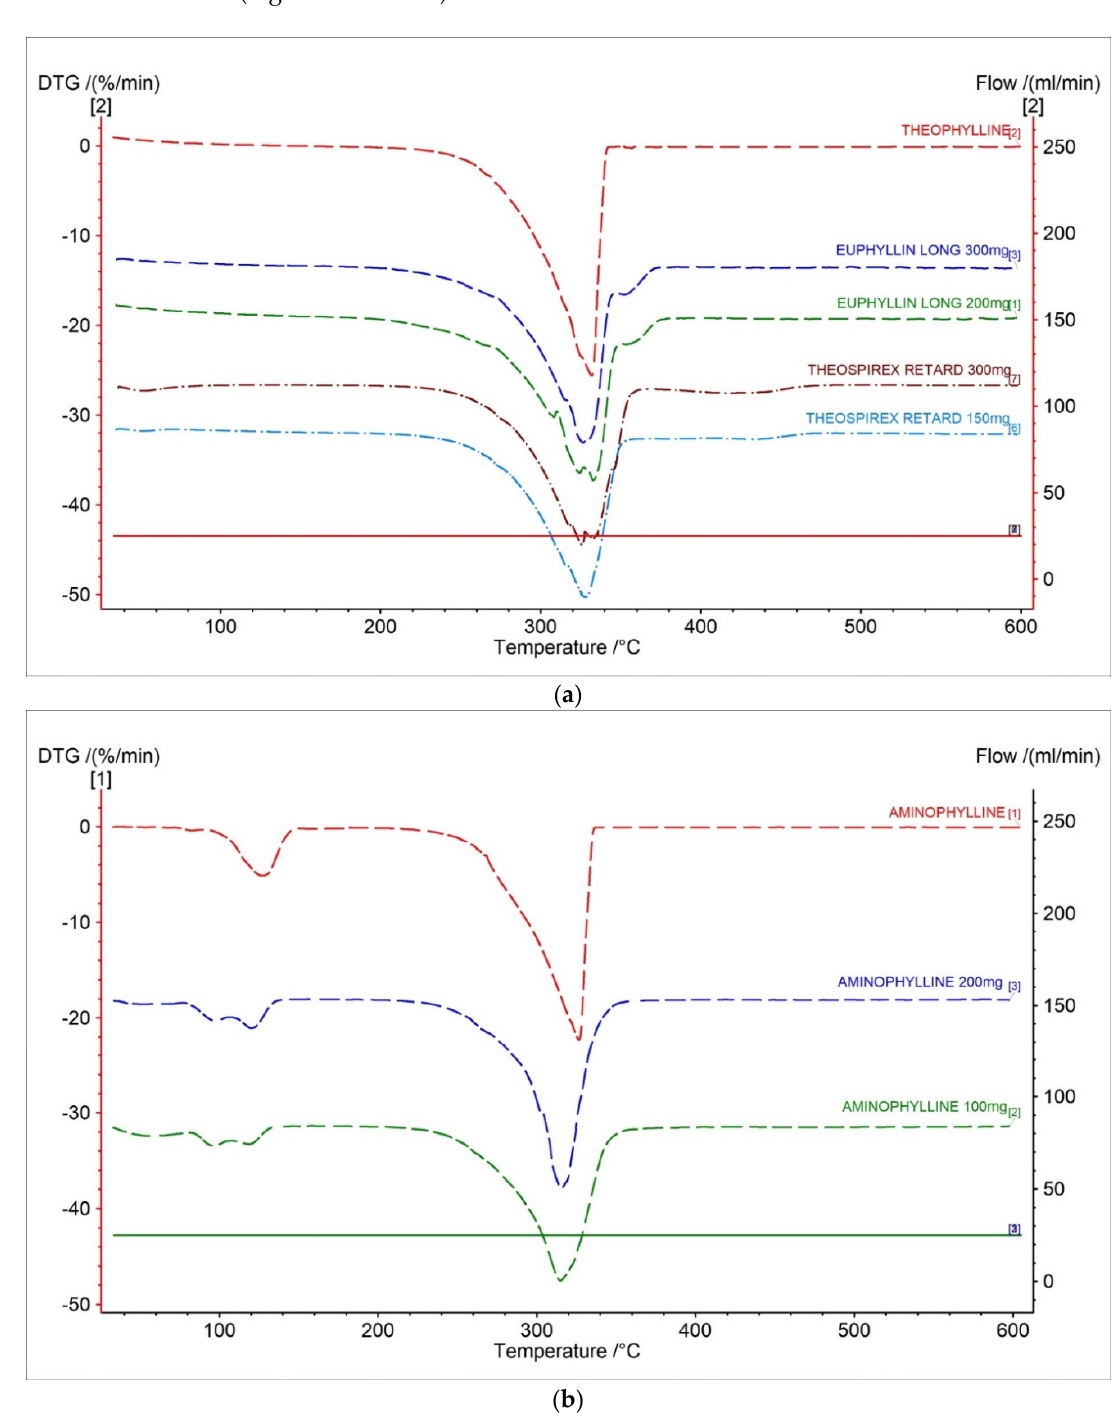
Figure 3. DTG curves for ( a ) theophylline standard, ( b ) aminophylline standard and pharmaceutical preparations containing theophylline, and aminophylline.